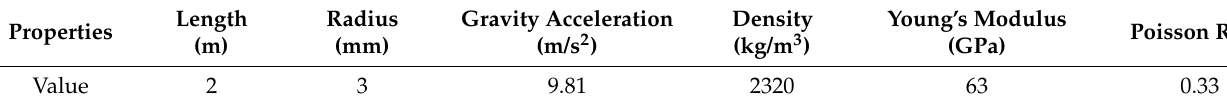
Figure 5. Flexible pendulum model.